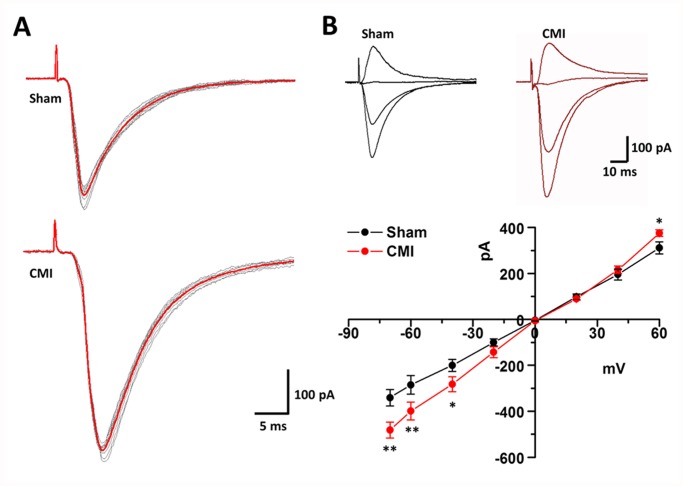
CMI potentiated tractus solitaries stimulation-evoked monosynaptic responses in the SolM.(A) Representative sample traces showing the single (gray) and averaged (red) monosynaptic responses induced by tractus solitaries stimulation in rats with sham surgery (up) or CMI (down). The monosynaptic nature was clarified by the constant latencies and small jitter. (B) Inset samples showing the superimposed monosynaptic responses at various holding potentials (-70, -40, 0 and +40 mV) in rats with sham surgery or CMI. The plotted figure shows the averaged I–V curve of the evoked responses, indicating that there was a significant inward rectification of the I-V curve in rats with CMI. *, p < 0.05; **, p < 0.001 compared with the sham group.